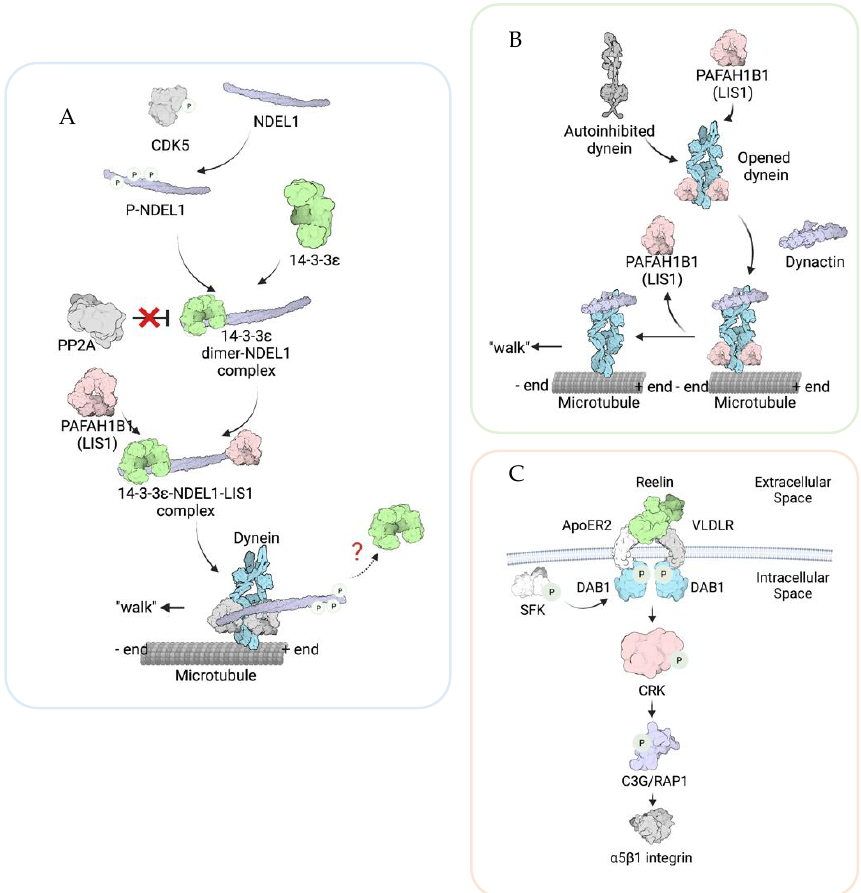
Figure 2. Schematic diagrams illustrating the molecular mechanisms of PAFAH1B1 (LIS1), CRK, and 14-3-3 ε in regulating neuronal migration. ( A ) Phosphorylated NDEL1 (NUDEL) protected by 14-3-3 ε from dephosphorylation. NDEL1 is phosphorylated by CDK5. Once phosphorylated, 14-3-3 ε interacts with NDEL1 and protects it from the protein phosphatase 2 (PP2A)-mediated dephosphorylation. Therefore, NDEL1 could stay activated. Active NDEL1 transiently interacts with PAFAH1B1 (LIS1) and helps PAFAH1B1 (LIS1) bind to dynein, therefore promoting the movement of dynein along microtubules (MTs). However, it is unclear whether 14-3-3 ε stays with dynein in the MTs. ( B ). PAFAH1B1 (LIS1) promotes dynein “open” conformation. When dynein is in an autoinhibited state, it has a low microtubule on rate and a reduced ability to bind to dynactin. PAFAH1B1 (LIS1) binds to “open” state dynein and stabilizes dynein at the “open” state. This allows dynein to stay at a high microtubule-binding status. Afterward, PAFAH1B1 (LIS1) dissociates from the dynein–dynactin complex. In this way, PAFAH1B1 (LIS1) promotes microtubule mediate migration by regulating dynein function. ( C ) CRK plays an essential role in the Reelin signaling cascade. Reelin pathways are activated by Reelin interacting with the transmembrane Reelin receptors, ApoRE2, and VLDLR. This triggers the phosphorylation of Dab1 by SFK at the inner leaflet of the plasma membrane. DAB1 then recruits CRK and activates CRK by phosphorylation. Activated CRK promotes the activation of the Crk SH3-binding guanine nucleotide-releasing/exchange factor (C3G)/Ras-proximate-1 (RAP1) pathway, which activates the cell matrix adhesion molecule α 5 β 1 integrin, thus promoting cell migration. The illustrations were created with BioRenders.com (7 December